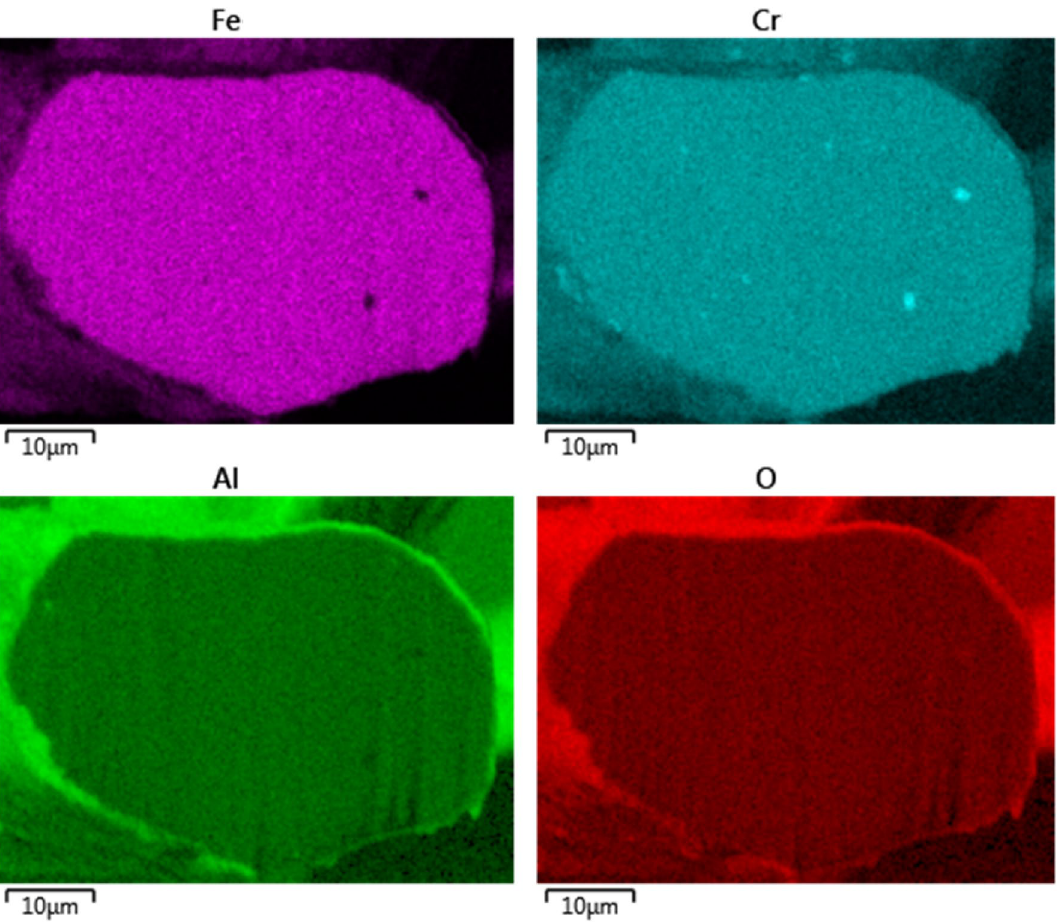
Figure 9. EDS mapping of iron, chromium, aluminum, and oxygen of Sample